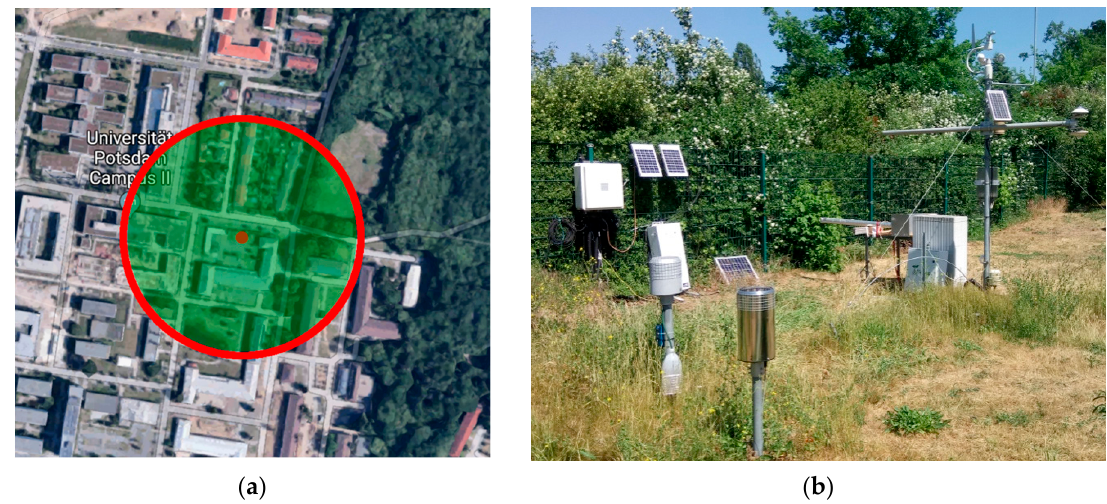
Figure 4. ( a ) Campus of Potsdam University, red point is where CRNS probes were installed and the red circle is the footprint. ( b ) Picture of the installation.